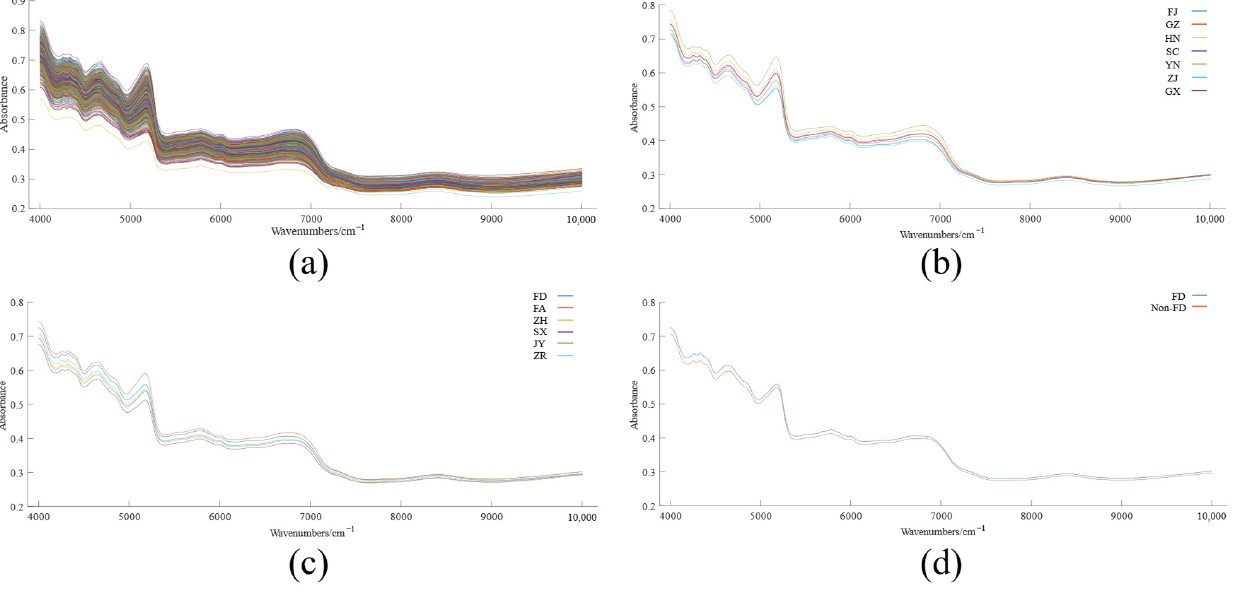
Figure 2. NIRS of white tea samples. ( a ) Original NIRS of 579 white tea samples; ( b ) average NIRS of white tea from different provinces; ( c ) average NIRS of white tea from different production districts in Fujian Province; ( d ) average NIRS of FD white tea and non-FD white